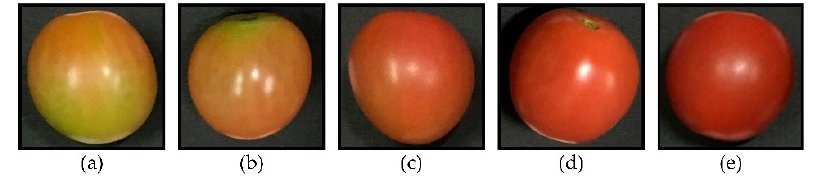
Figure1. Diagram for pickingand distributionfor tomatoonline retailing basedon postharvestmaturity. Figure 1. Diagram for picking and distribution for tomato online retailing based on postharvest maturity.